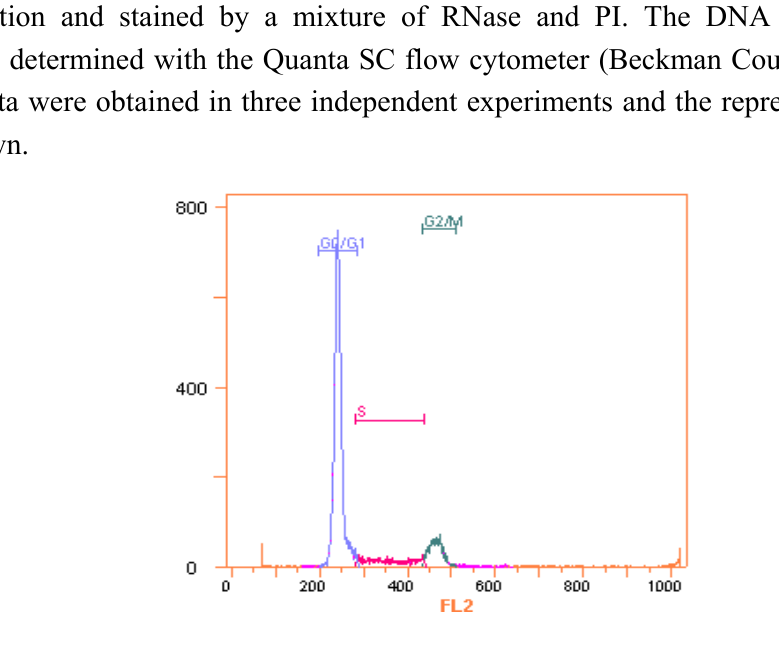
Figure 1. DNA content histogram of Jurkat cell line using single parameter flowcytometry method (PI staining). Cells were fi xed in ice-cold 70% (v/v) ethanol for 24 h, collected